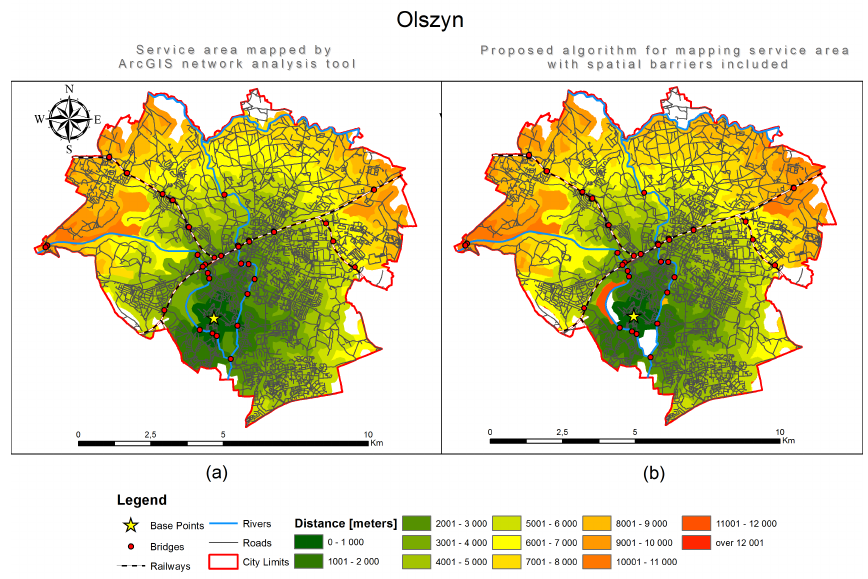
Figure 11. Service areas identified in the city of Olsztyn: ( a ) results generated by the standard network analysis tool in ArcGIS; ( b ) results generated by the algorithm developed in the ModelBuilder application in ArcGIS.